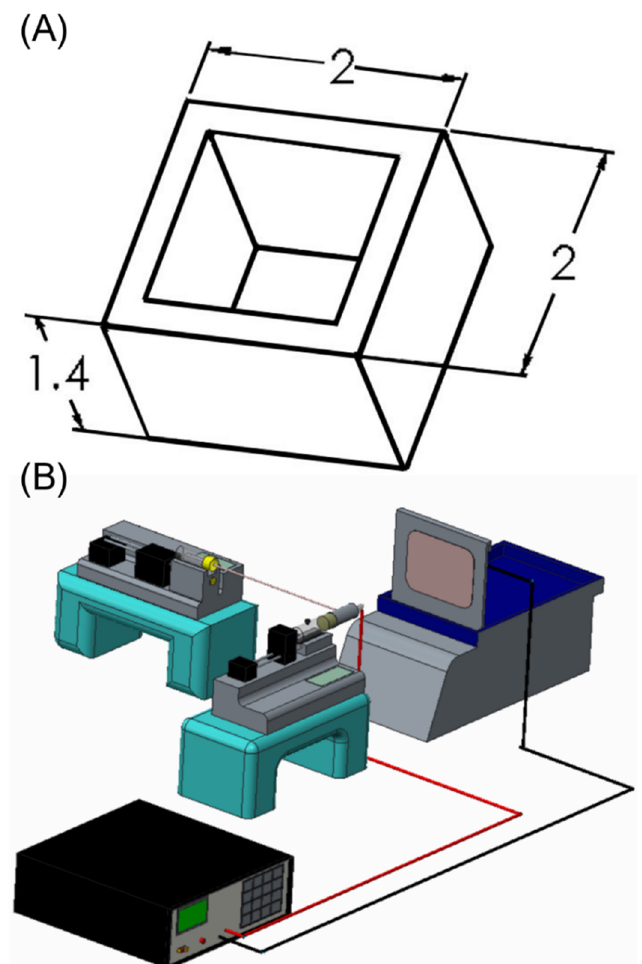
Figure 1. ( A ) Layout and dimensions of PLA scaffold (unit: mm, thickness = 0.5 mm), ( B ) the coaxial electrospinning device used to prepare the drug-eluting nanofibers.